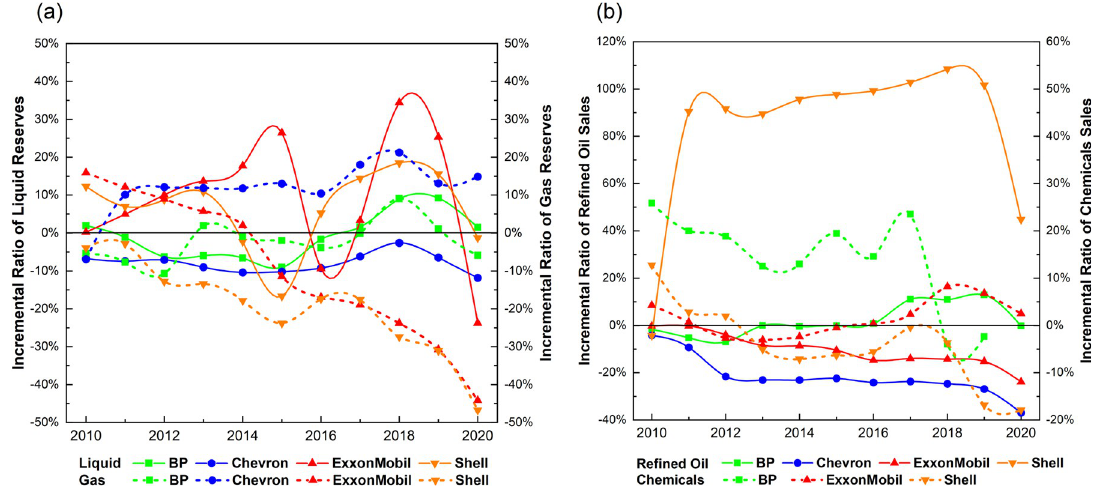
Fig 6. Fossil fuel reserves and petroleum sales. (a) Fossil fuel reserves in the incremental ratio (2010~2020). (b) Petroleum sales in the incremental ratio (2010~2020). Note: Results for Chevron are not included in (b), since its data on chemical sales are not publicly disclosed. BP’s data on chemical sales in 2020 is not